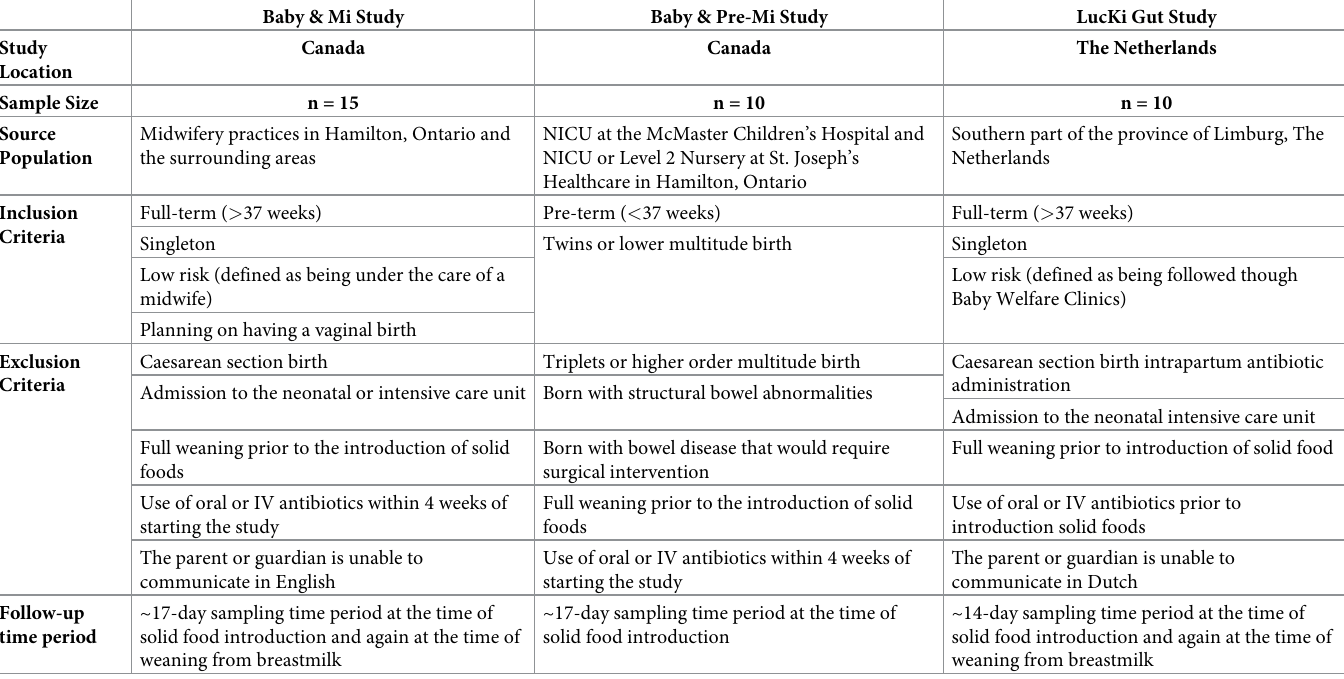
Table 1. Descriptive summary of the three cohorts that form the Intensively Sampled sub-study. Baby & Mi